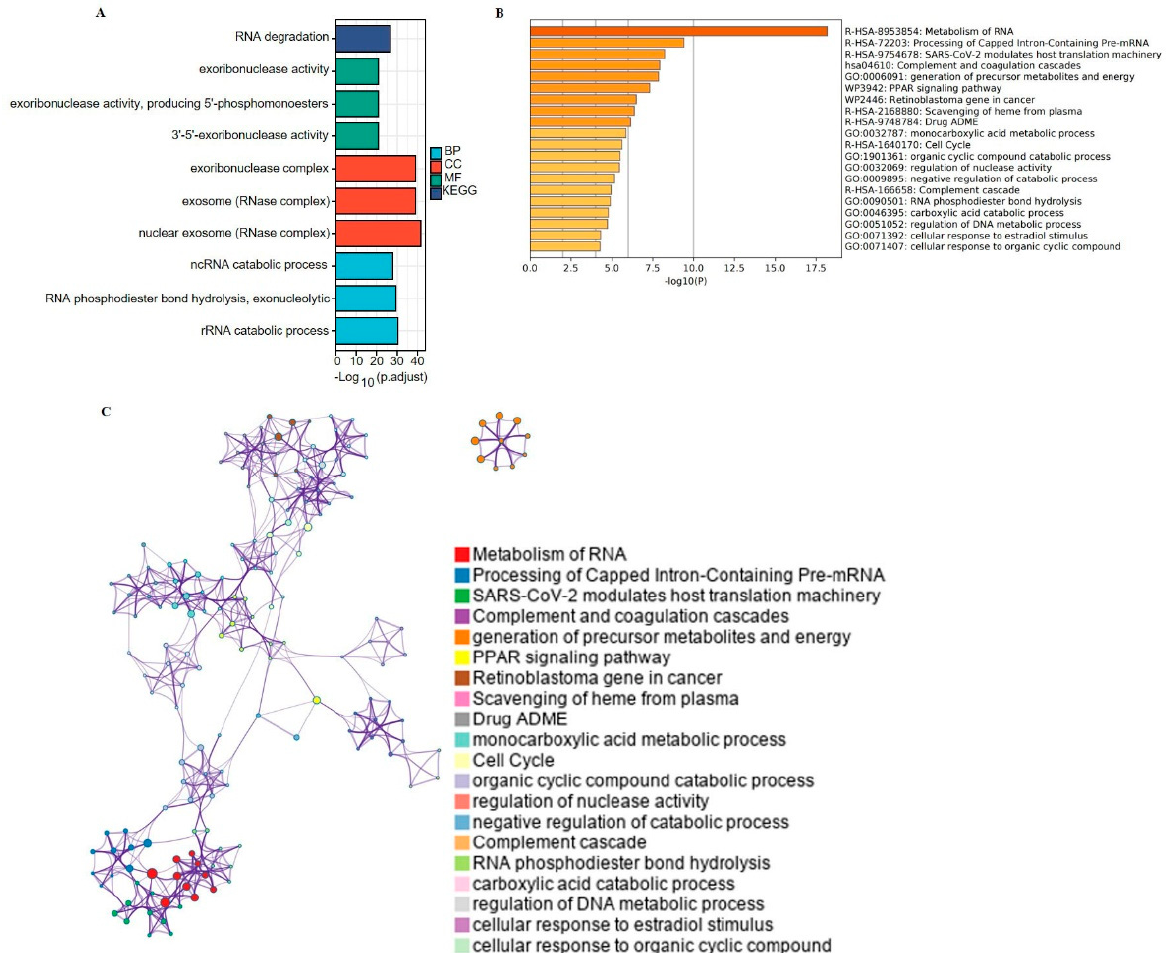
Figure 6. Functional and pathway enrichment analyses of EXOSCs. ( A ) Top significantly enriched GO terms of EXOSCs, including BP, CC, MF and KEGG. ( B ) KEGG enriched terms colored by p values. ( C ) Network of enriched terms colored by p values.